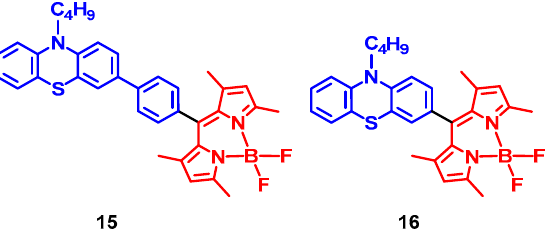
Figure 4. Phenothiazine-Bodipy dyads showing SOCT-ISC.